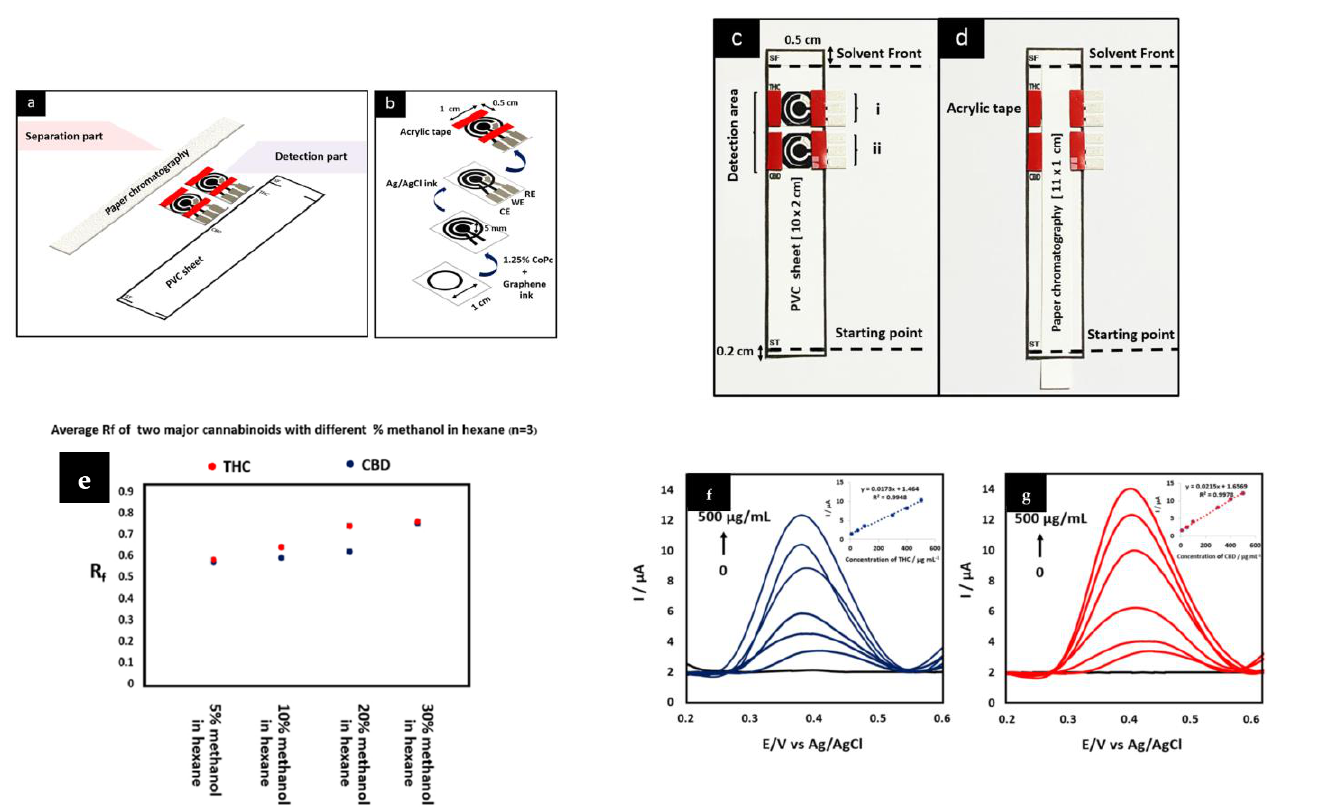
Figure 3. ( a ) Three major parts of the device, including the PVC sheet (substrate), modified screen printed electrodes (detection part), and chromatographic paper (separation part). ( b ) Functionaliza- tion process for modifying graphene ink with 1.25% cobalt phthalocyanine (CoPc) and printing Ag or AgCl ink on the substrate for fabricating reference electrode. ( c ) The device after mounting the detection part and ( d ) the separation part on the PVC sheet. ( e ) Different methanol concentrations in hexane and their influence on the amount of retardation factors ( R f ) of CBD (black spots), ∆ 9 -THC (red spots) in the mobile phase, and DPV signals. The calibration curves of ( f ) ∆ 9 -THC and ( g ) CBD were obtained from CoPc modified-screen printed graphene electrode (CoPc/SPGE) in 0.1 M PBS with pH 7.0. Reprinted and adapted with permission from ref. [7]. Copyright 2022 Elsevier. Table 2. A comparison between conventional material-based electrochemical sensors for detecting ∆ 9 -THC and CBD in terms of their sensing performance and working-functional